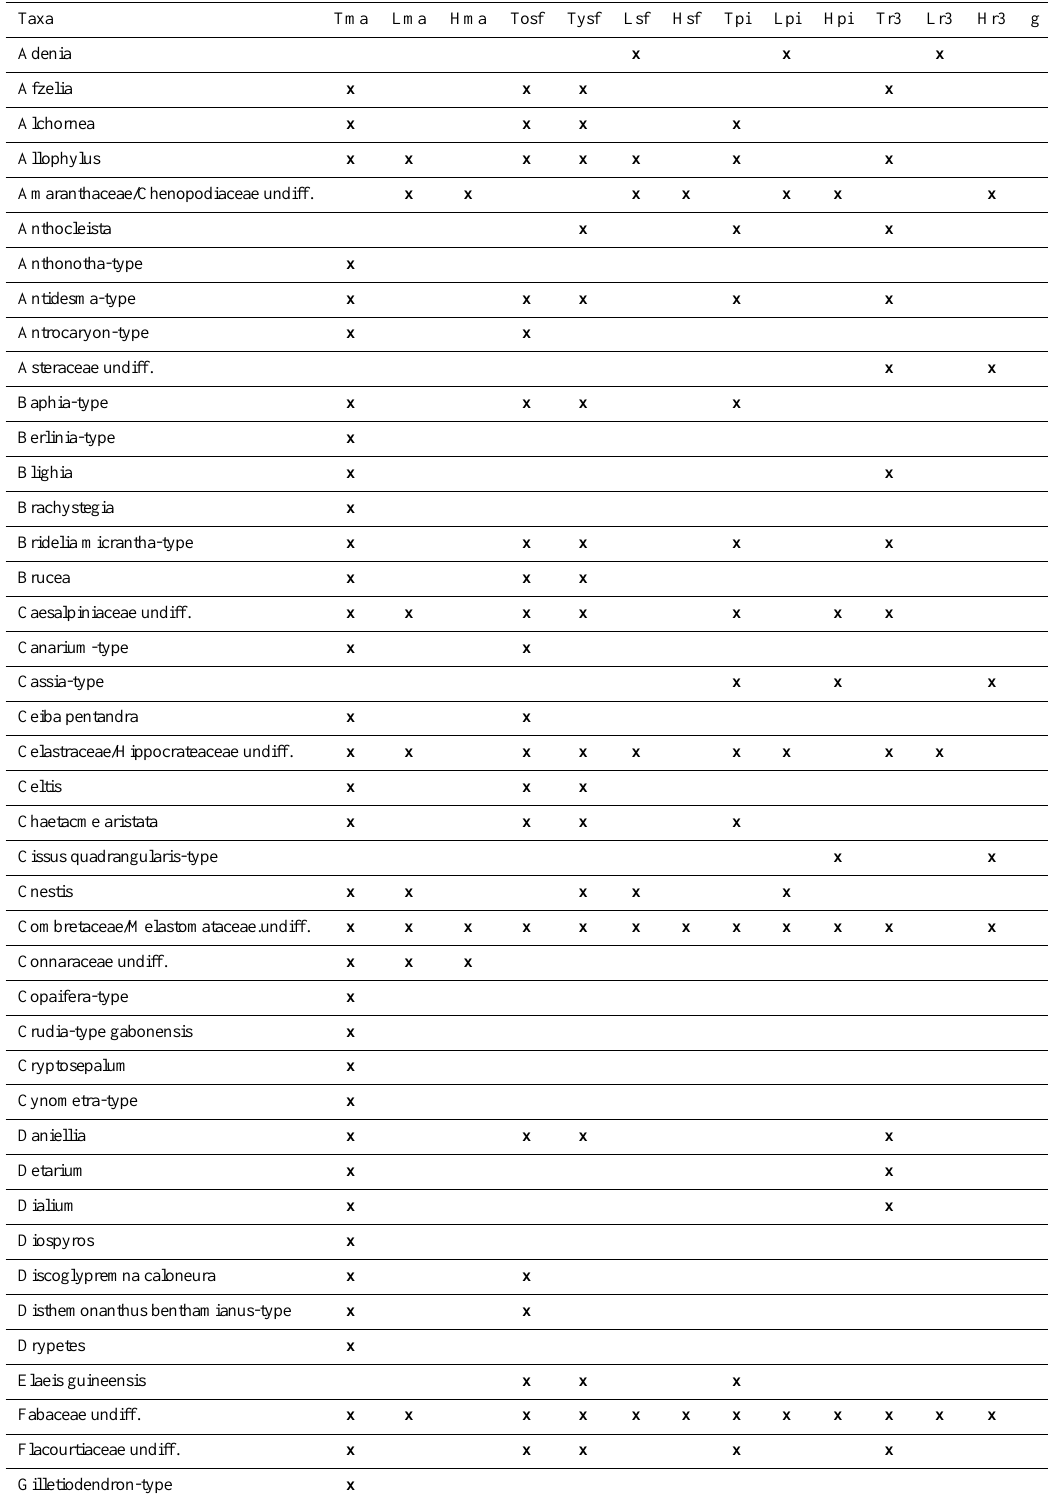
Table 3. Allocation of the pollen taxa identified in the Barombi Mbo sequence to the plant functional types (PFTs) used in dynamic